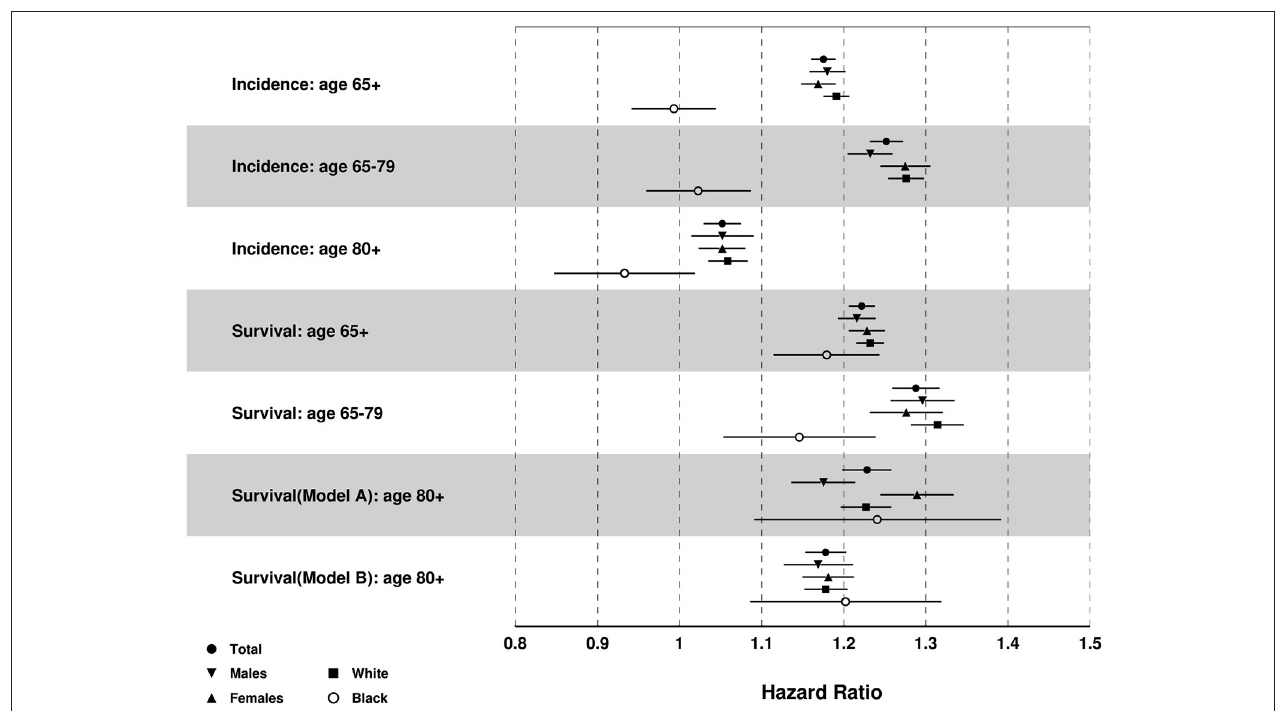
FIGURE 6 | Results of multivariate Cox proportional hazards regression for MI incidence and death after MI diagnosis: Adjusted hazards ratio (HR) [95% CI] of lagging vs. leading states. Note: Age was controlled for incidence, and age of diagnosis was controlled for survival after MI